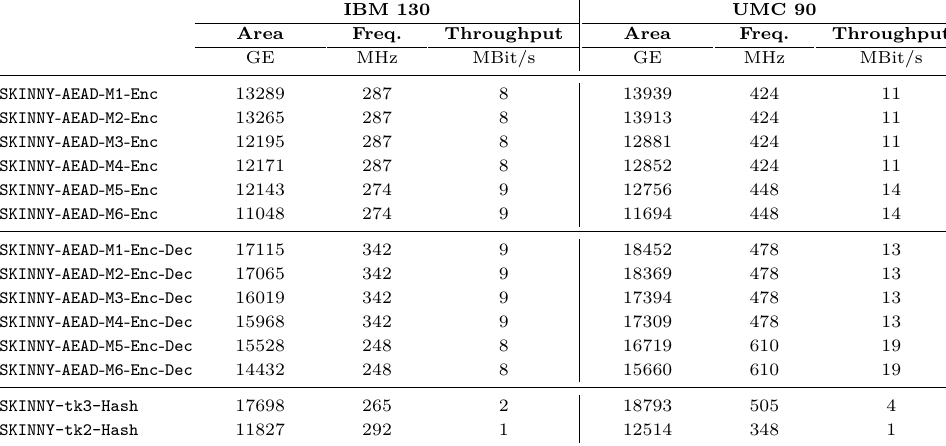
Table 12: SCA-protected (2 shares), byte-serial ASIC implementations of SKINNY-AEAD and SKINNY-Hash members. IBM